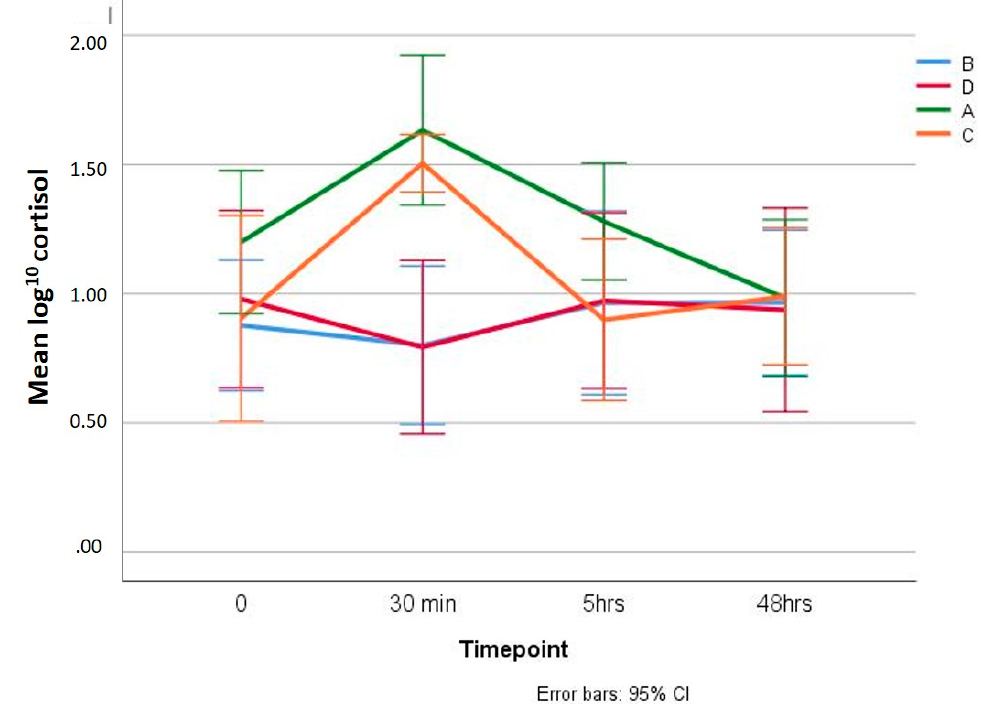
Figure 2. Mean of log 10 cortisol in the four Groups A, B, C, and D, prior to tail docking (C0), and at 30 min (C1), 5 h (C2) and 48 h (C3) intervals post-tail excision (Error bar: 95% CI). Groups A and C, the tail was excised with a scalpel without anaesthesia or stitches; Groups B and D, the tail was surgically excised and stitched under GA; with Groups C and D immediately sprayed with PR.